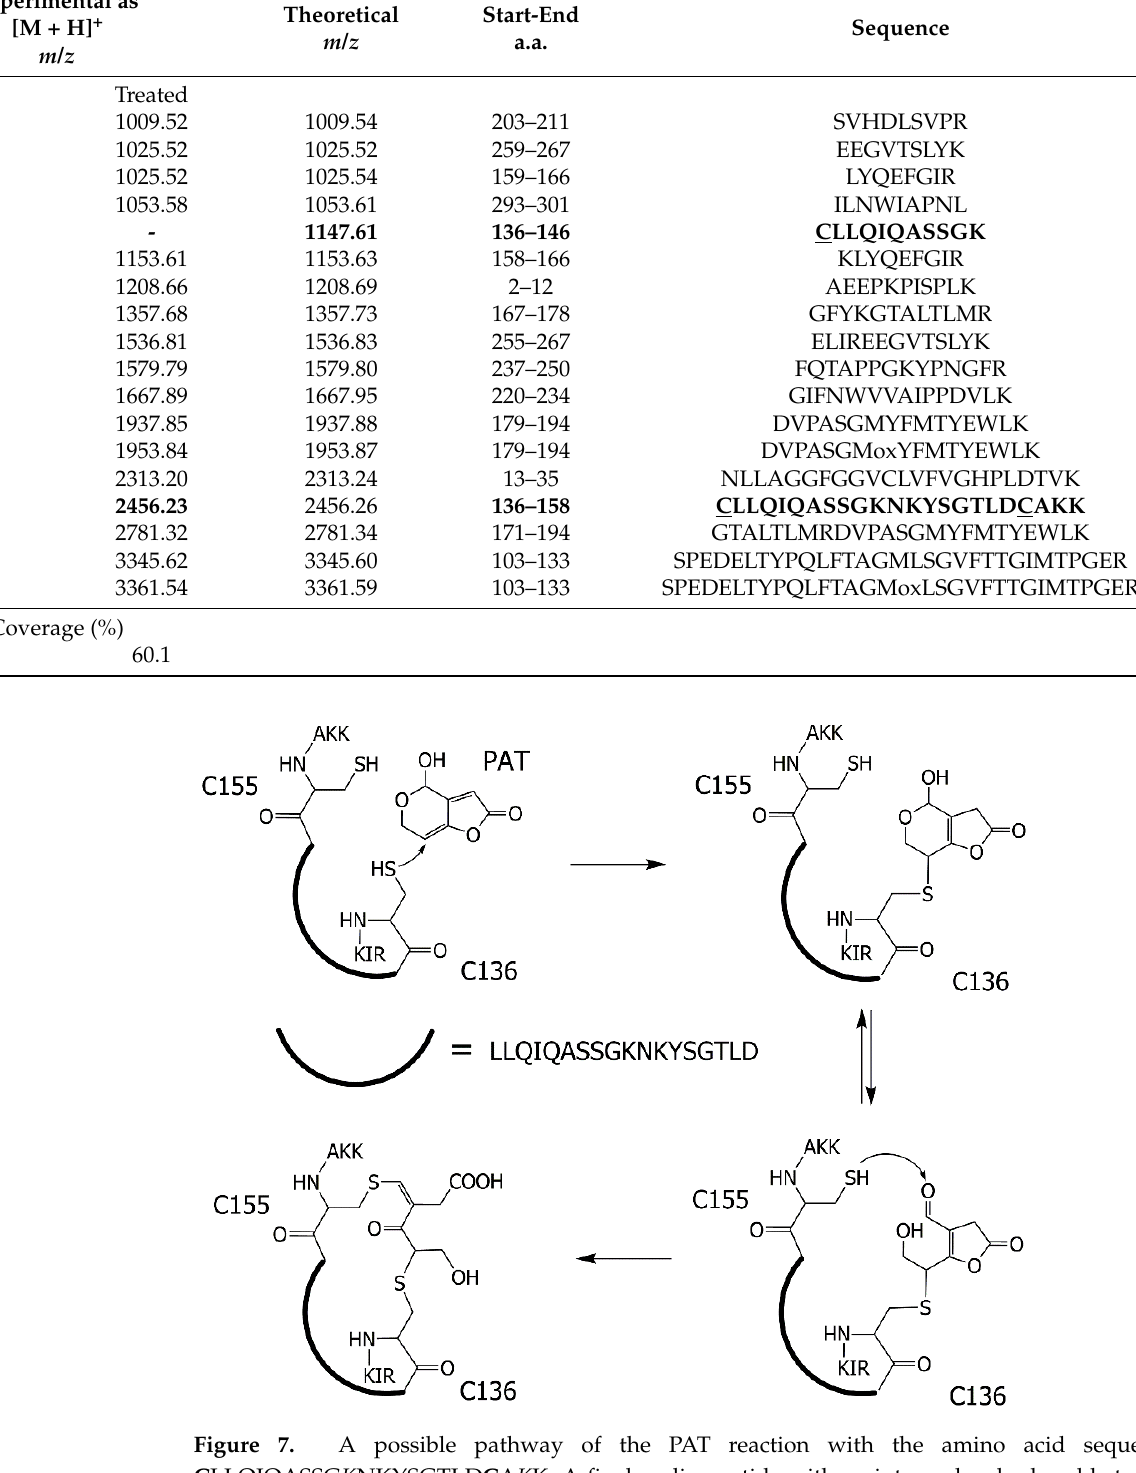
Figure 7. A possible pathway of the PAT reaction with the amino acid sequence C LLQIQASSG K NKYSGTLD C A K K. A final cyclic peptide with an intramolecular bond between C136, PAT and C155 was hypothesized. For residues preceding C136 (133-RIK-135) and following C155 (156-AKK-158), see also Figure 5.